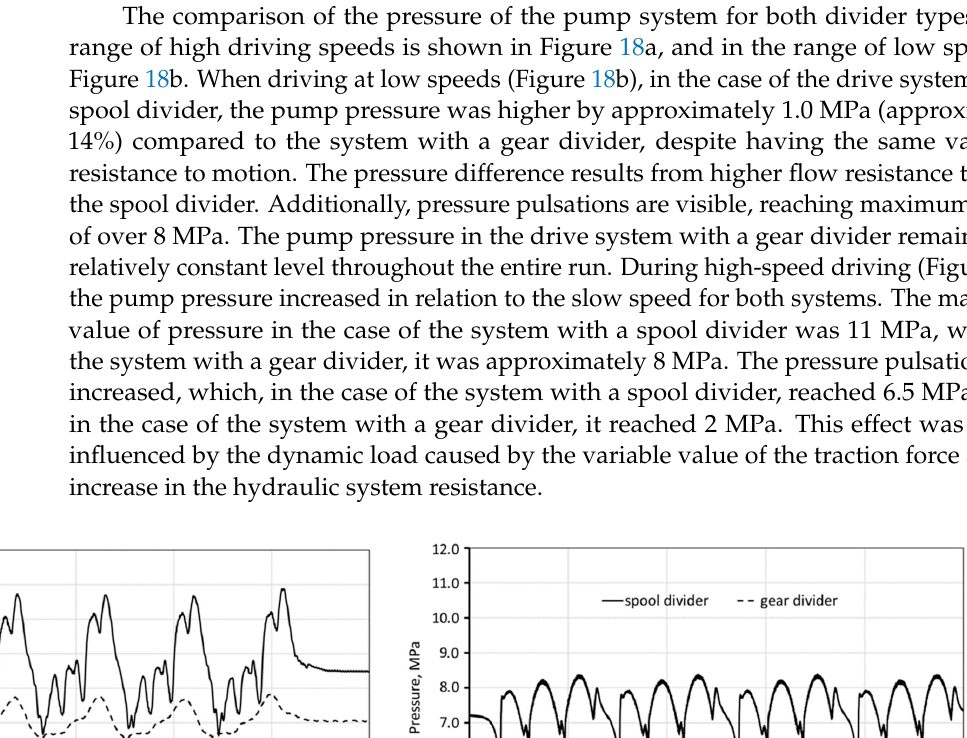
Figure 17. Torque on wheels with 25% of nominal pump flow for spool flow divider ( a ) and gear-type flow divider ( b ). The comparison of the pressure of the pump system for both divider types in the